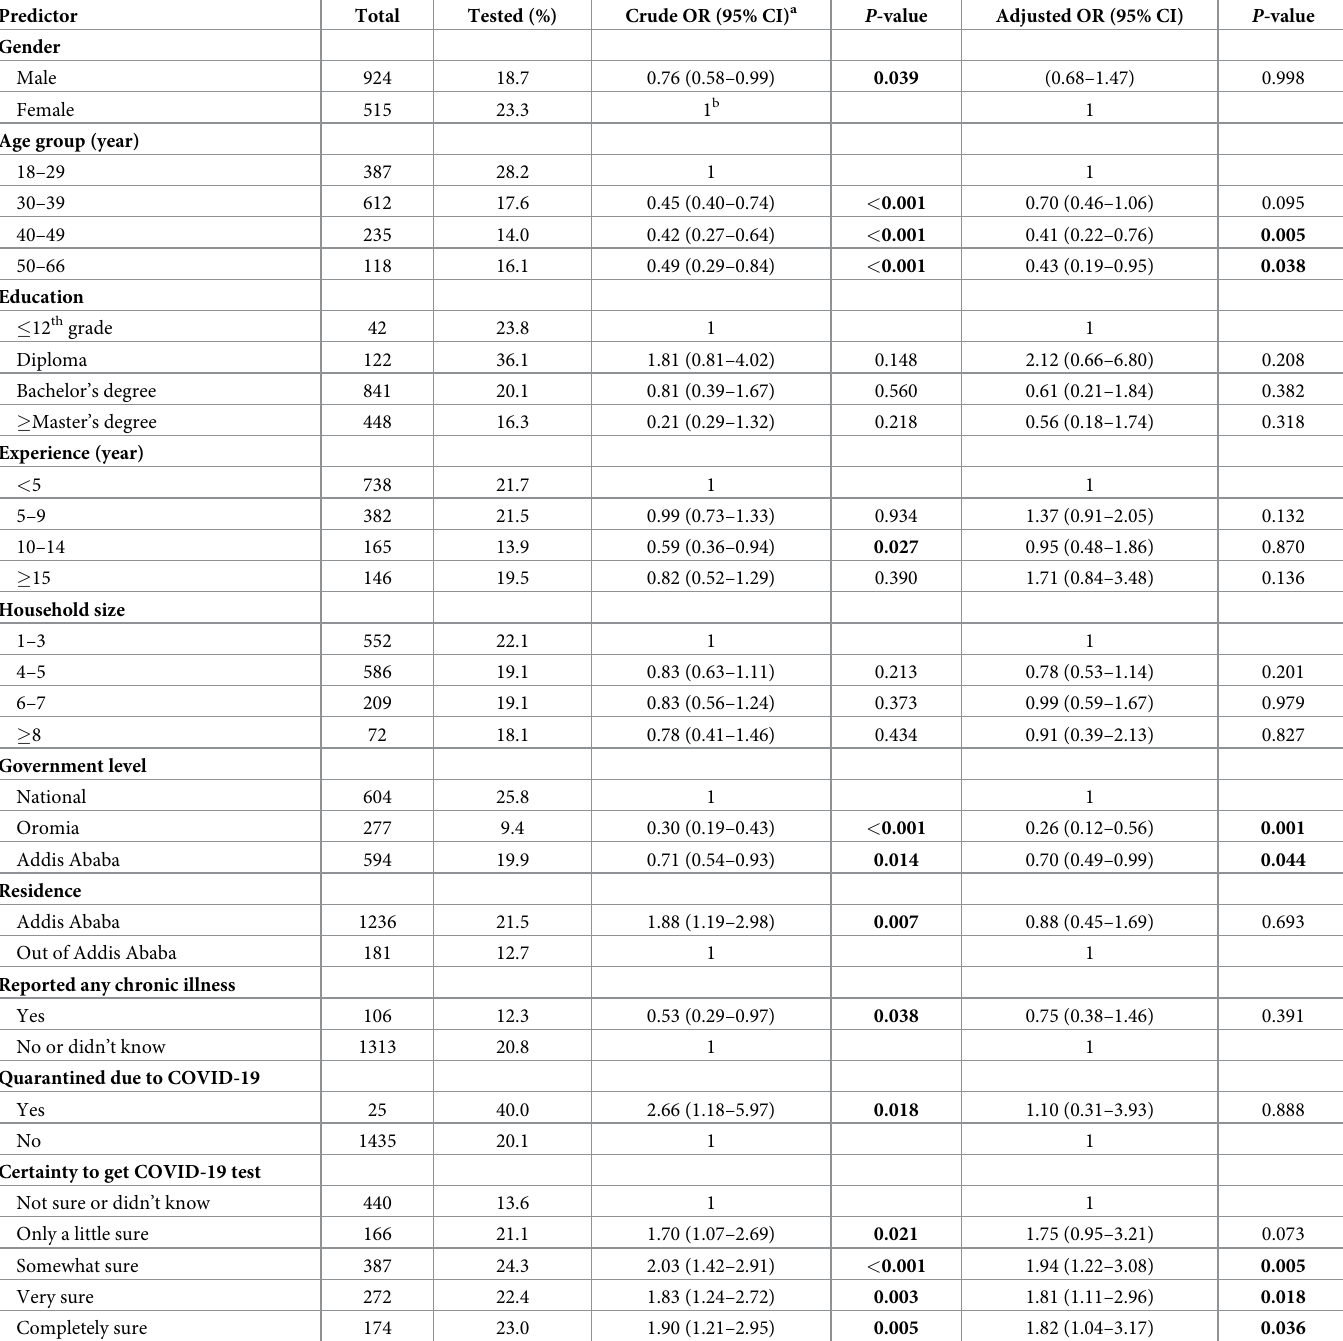
Table 4. Factors associated with coronavirus testing in the study population using bivariate and multivariable logistic regression analyses, Addis Ababa, June